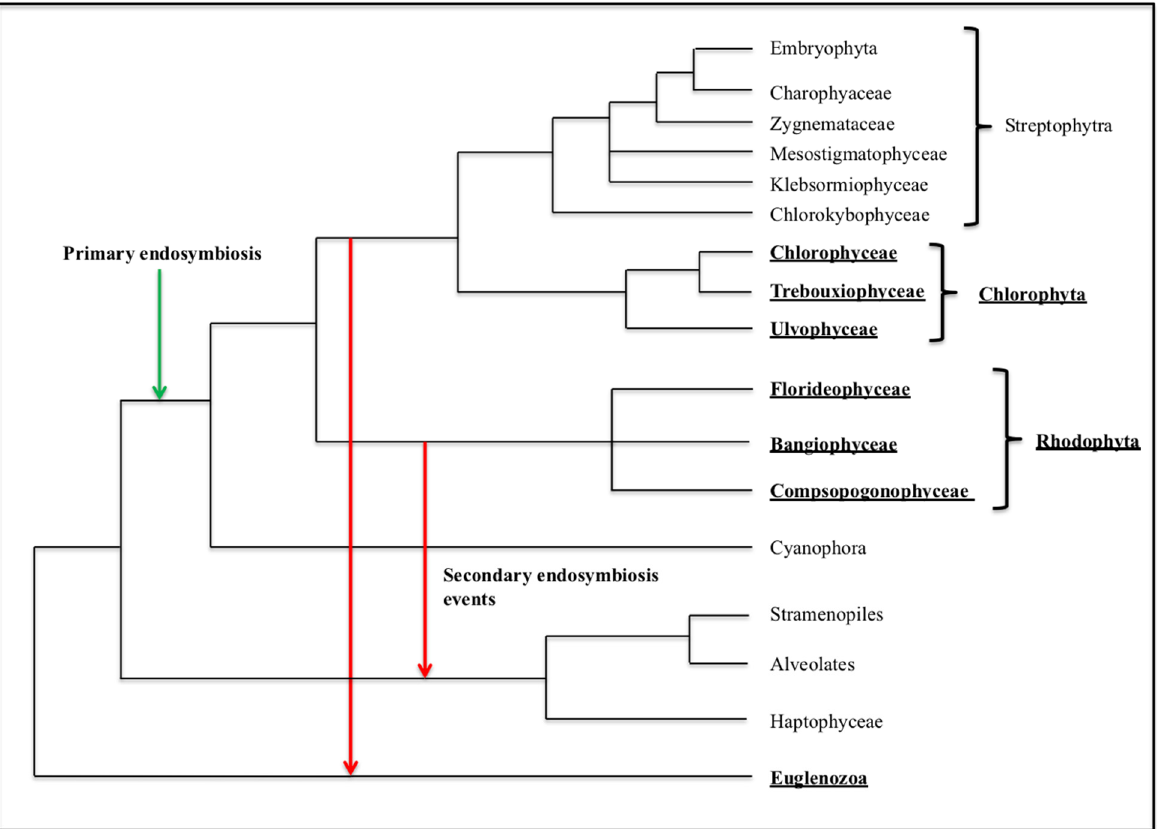
Figure 5. Distribution of skew pattern genomes in a phylogenetic framework using the general relationships in ref. [17]. The lineages with multiple skew-pattern genomes, here defined as those that have at least one significant walk and co-location of I AT and I GC , are in bold and underlined.